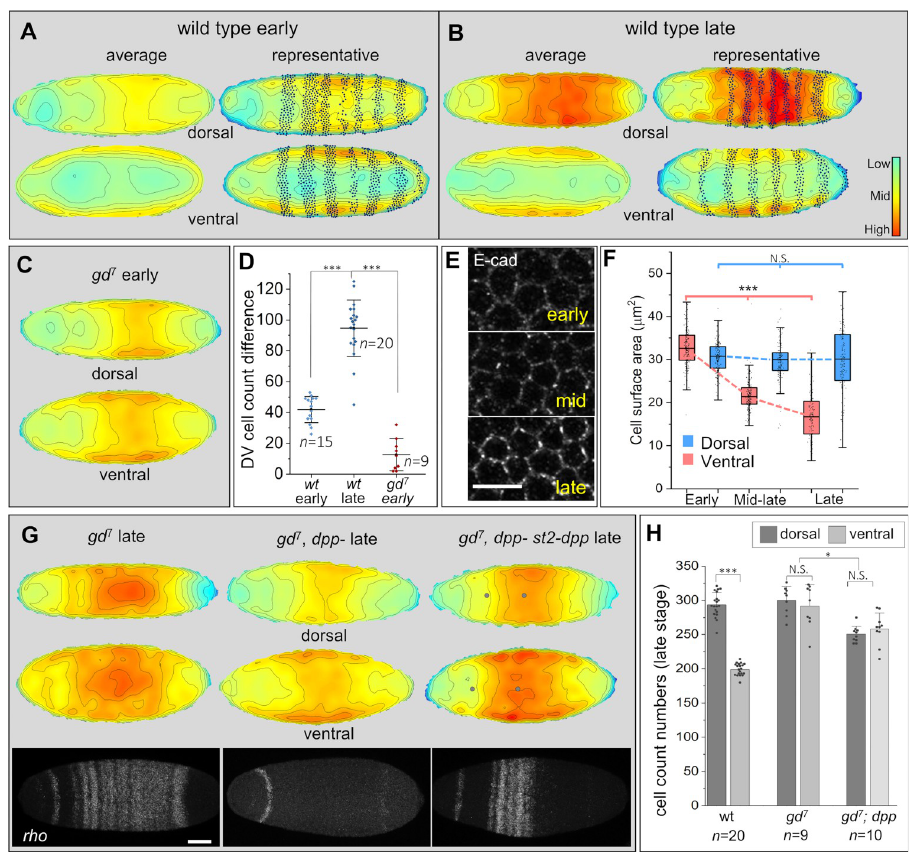
Fig 1. AU : AbbreviationlistshavebeencompiledforthoseusedinFigs 1 to 7 : Pleaseverifythatallentriesarecorrect : DPP is the morphogen that attracts cells dorsally. (A, B) Cell density heatmaps of dorsal and ventral sides of wild-type embryos at early (A) and late (B) cellularization stages. “Average heatmaps” combine data of 9 embryos for all genotypes, except for gd 7 ; dpp- ( n = 5). “Representative heatmap” shows a single embryo with A/P marker ftz (black dots). Note the higher dorsal cell density in early stage that increases in late stage. (C) gd 7 mutants with no DL gradient loose early asymmetry of cell densities. (D) Dorsal and ventral cell count differences of embryos shown in (A–C). (E) anti-E-CAD membrane labeling of dorsal cells in wild type during cellularization. (F) Quantification of cell constriction over time. Dorsal cells show significant decrease in segmented surface area from early to mid- to late stages, while ventral cells of same embryos do not. (G, H) DPP increases cell density in the absence of DL. (G) Average cell density heatmaps in late stage gd 7 embryos without DL gradient (top left). The high-density levels in ventral and dorsal surfaces is abolished when DPP is also removed ( gd 7 ; dpp- embryos, top center) and restored by the ectopic expression of dpp ( gd 7 ;dpp- st2-dpp embryos, top right; dots indicate margins of rho domain). Changes in the expression of DPP-target rho in these genetic backgrounds (bottom) confirm the manipulations. (H) Dorsal and ventral cell counts in wild type, gd 7 and gd 7 ;dpp- embryos at late cellularization stage. Error bars, standard deviation. N. S., not significant. Asterisks, threshold values based on p -values calculated with two-tail Mann–Whitney test (D, F, H, comparison of different genotypes and stages) or two-tailed Wilcoxon signed-rank test (H, comparison of D/V surfaces of same genotypes and stages). � p < 0.05, ��� p < 0.0001. Scale bars, 10 μ m AU : Pleasenotethatallinstancesof m marechangeto m m : Pleasecheck : (E) and 60 μ m (G). Metadata for the graphs shown in D, F, and H can be found at Supporting information S1 Metadata. A/P, antero-posterior; DL, dorsal; DPP, decapentaplegic; D/V, dorso-ventral; FTZ, fushi tarazu; GD, gastrulation defective; ST2, even skipped stripe